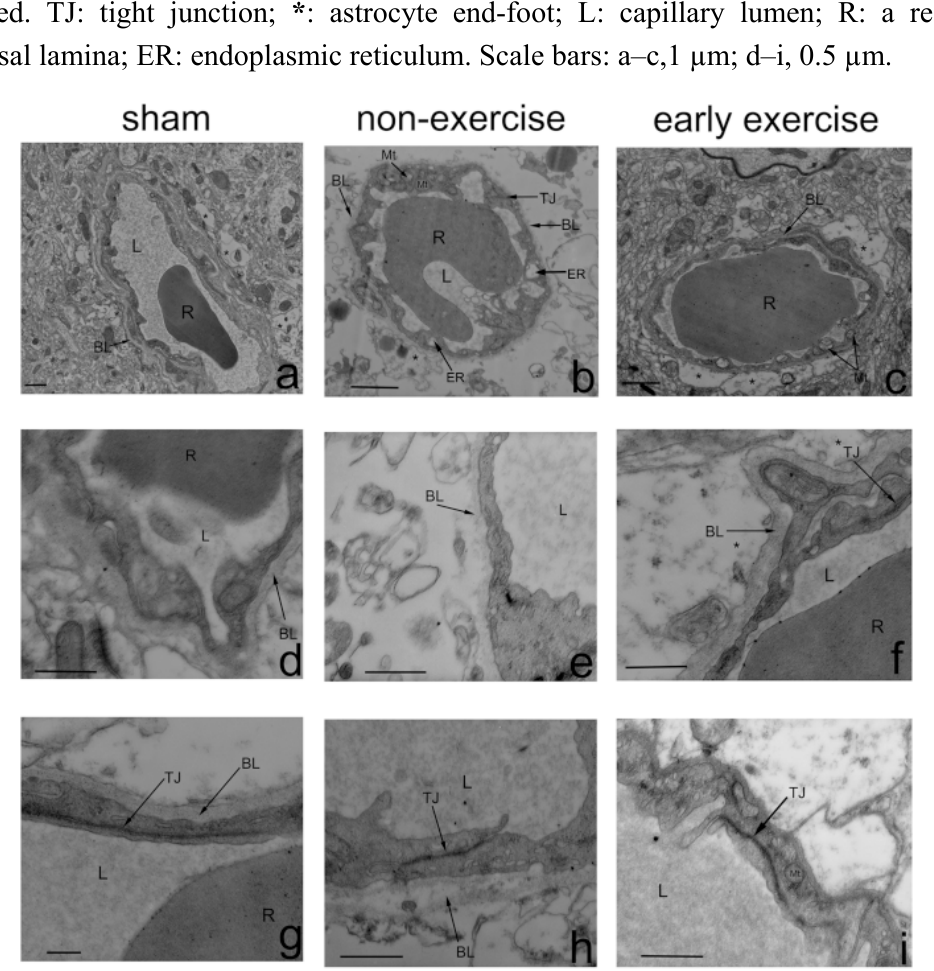
Figure 4. Effect of early exercise on the ultrastructure of the BBB in the ipsilateral cortex using transmission electron microscopy after three-days’ exercise. Permeability of the BBB in early-exercise rats remained compromised compared to NE rats. n = 4. a , d and g : In the sham group, tight junctions (TJs) and basement membranes (BLs) were intact. b , e and h : In the NE group, blood vessels were severely shrunken with reduced luminal areas, vacuoles were present in their mitochondria and their basement membranes were abnormally